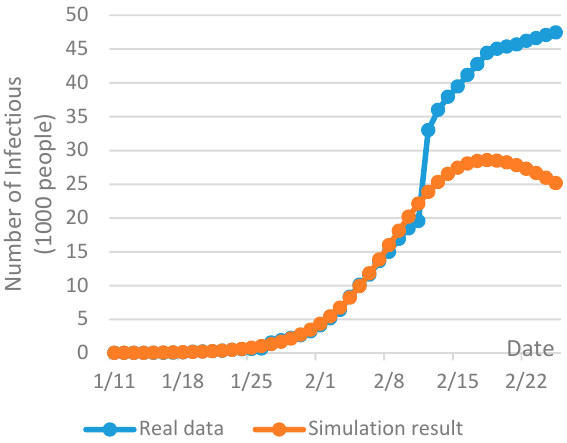
Figure 5. Comparison between the prediction on February 9th and the real data of the COVID-19 infections in Wuhan until February 26th.